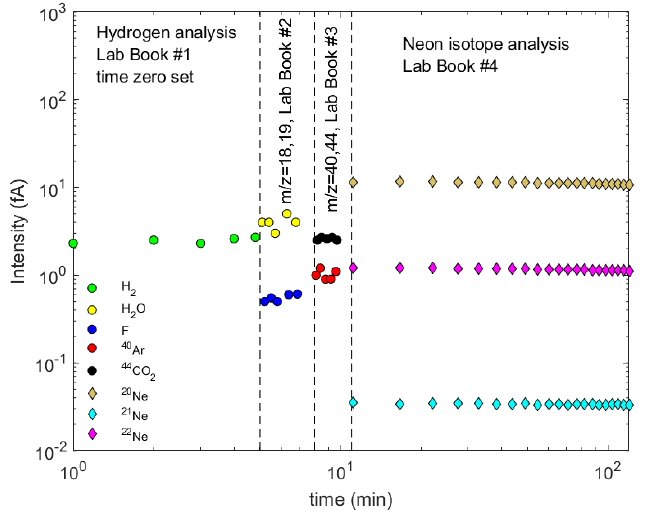
Figure 2. Schematic of the measurement protocol for high precision Ne analysis using the Thermo Fisher ARGUS VI mass spectrometer. The analysis was performed in four lab books in Qtegra to minimise magnet current movement when Ne isotopes were measured. Interfering compounds and hydrogen were measured first for 10 min. Ne isotope measurements were long enough to overcome the uncertainty introduced by the time gap.